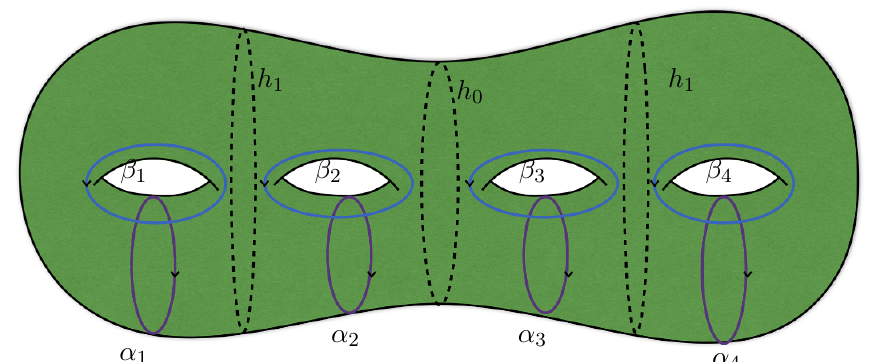
Figure 11 . Our genus four Riemann surface with (cid:11) cycles in purple and (cid:12) cycles in blue. There are three re(cid:13)ection symmetries along the horizontal and vertical axes, as well as in the plane of the